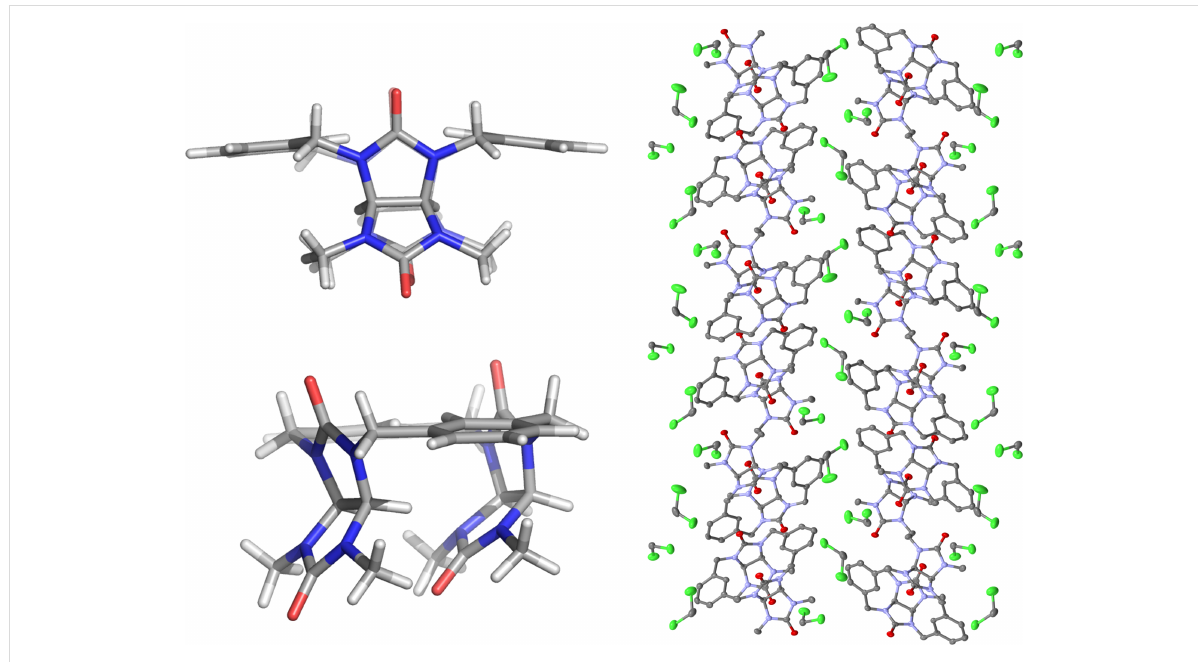
Figure 5: X-ray crystal structure of 1b-1 (left), layered structure of crystal packing (right).